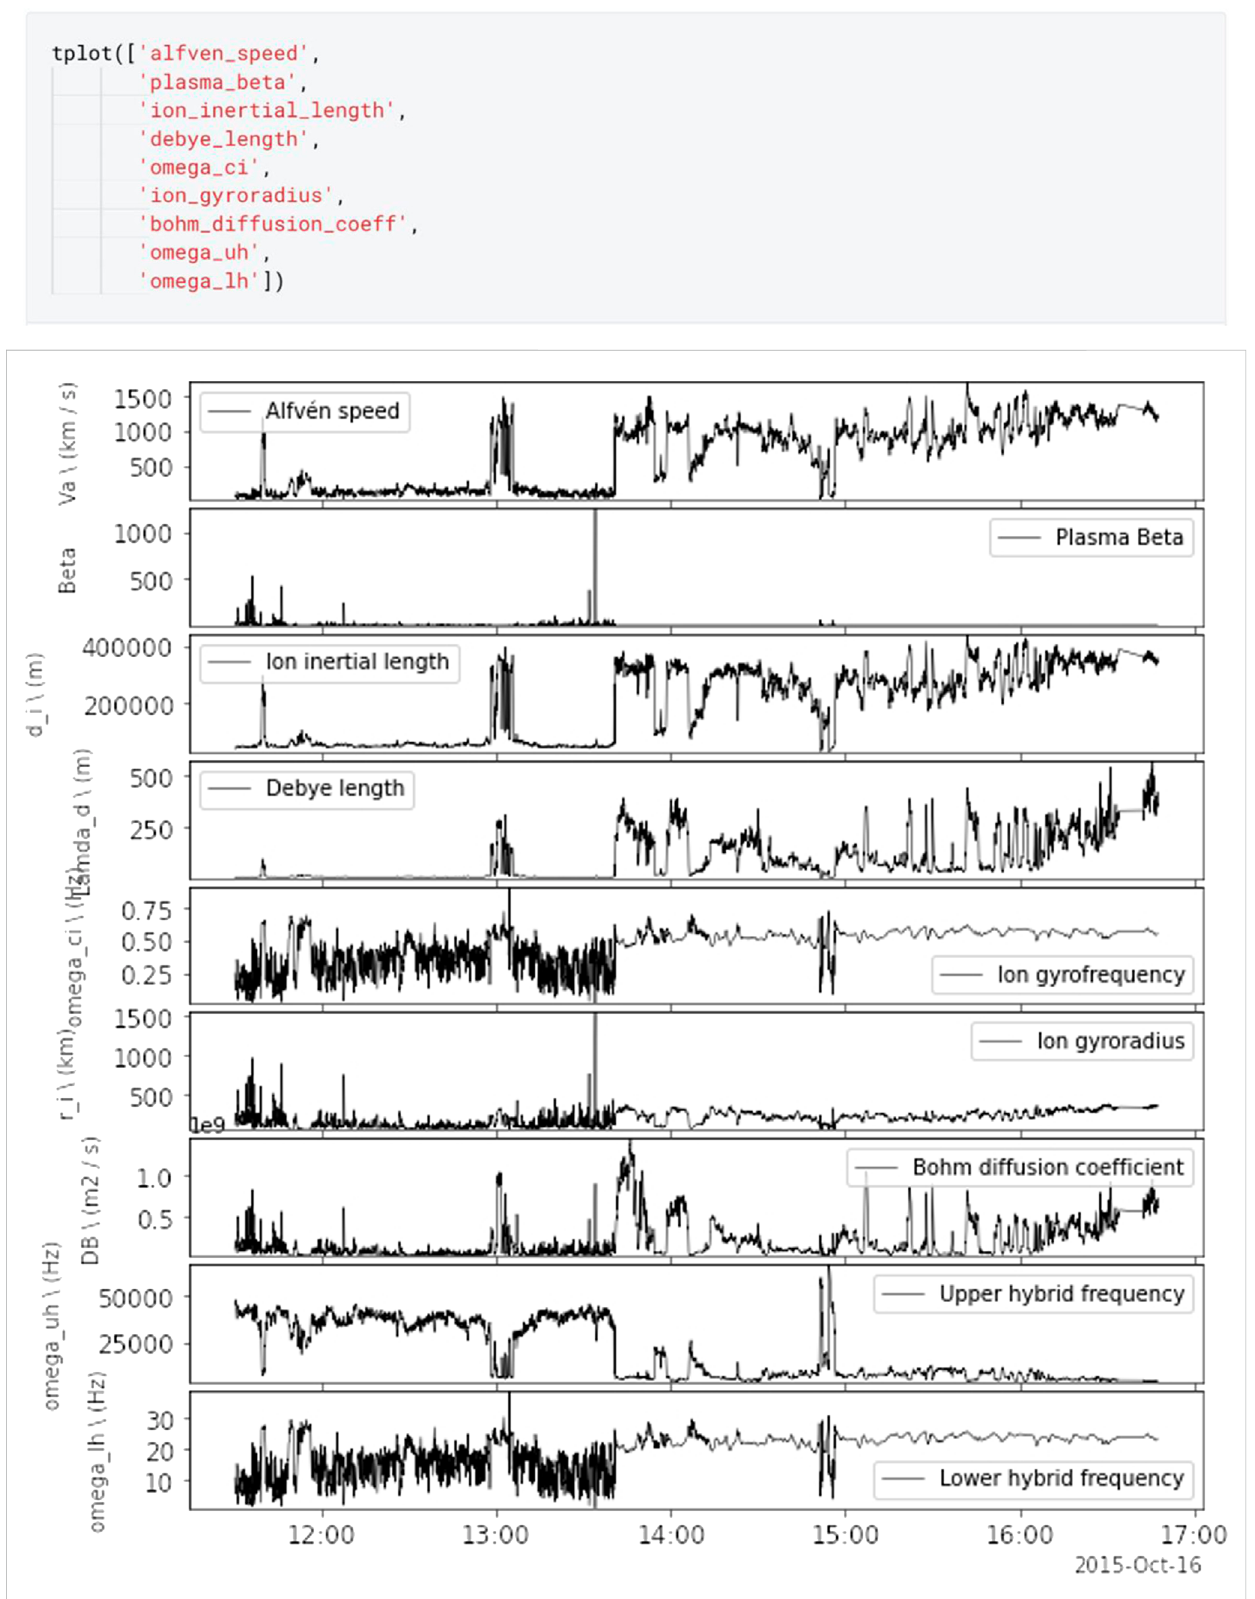
FIGURE 3 Timeseries plots showingthecalculatedplasmaparameters. Note thedramatic visualchanges between13:00 – 14:00 and thespikesjustbefore15:00.